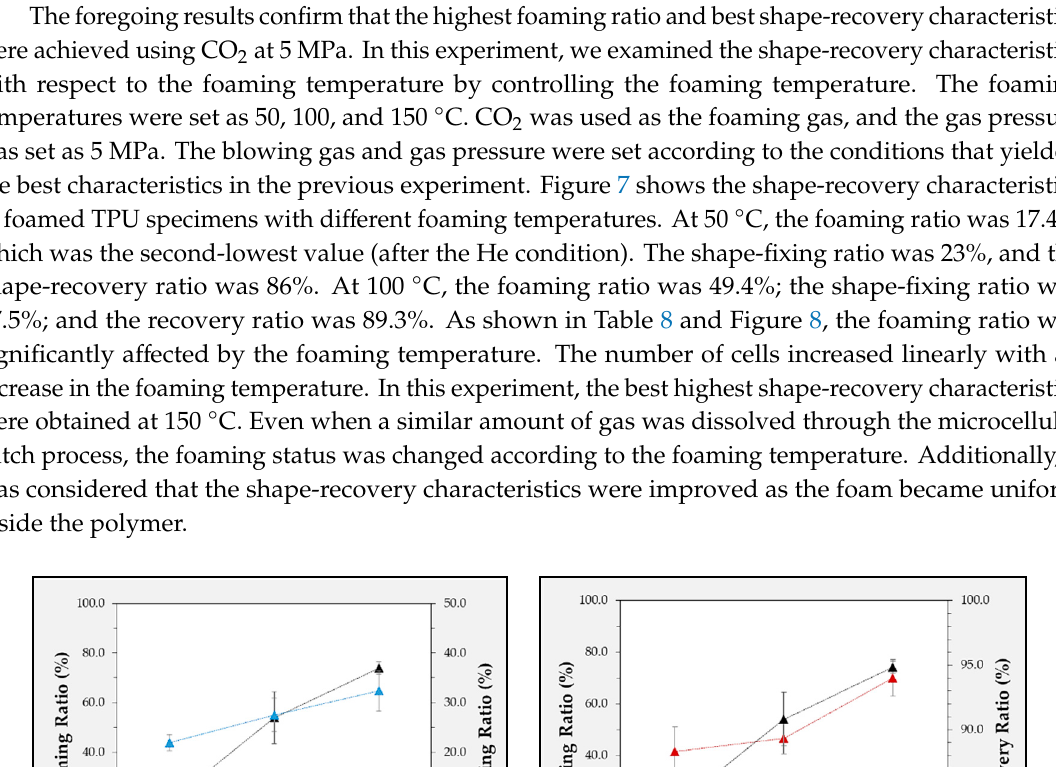
Figure 6. Cross-sectional SEM images of TPU specimens at different saturation pressures.